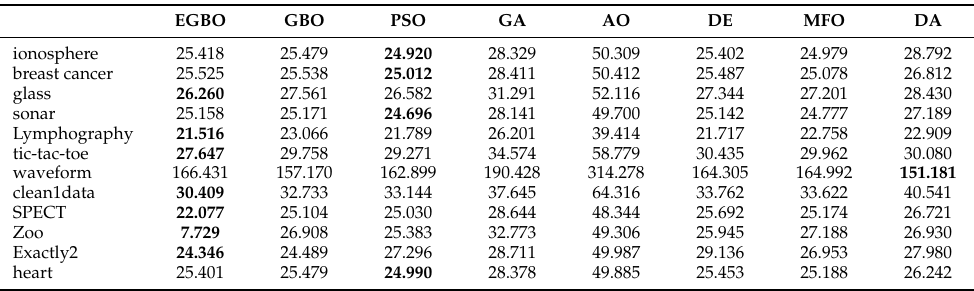
Table 12. Computation times for all